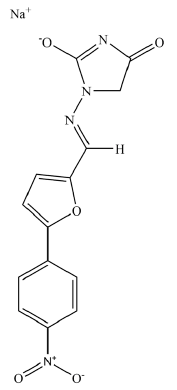
Figure 1. Structure of dantrolene sodium.